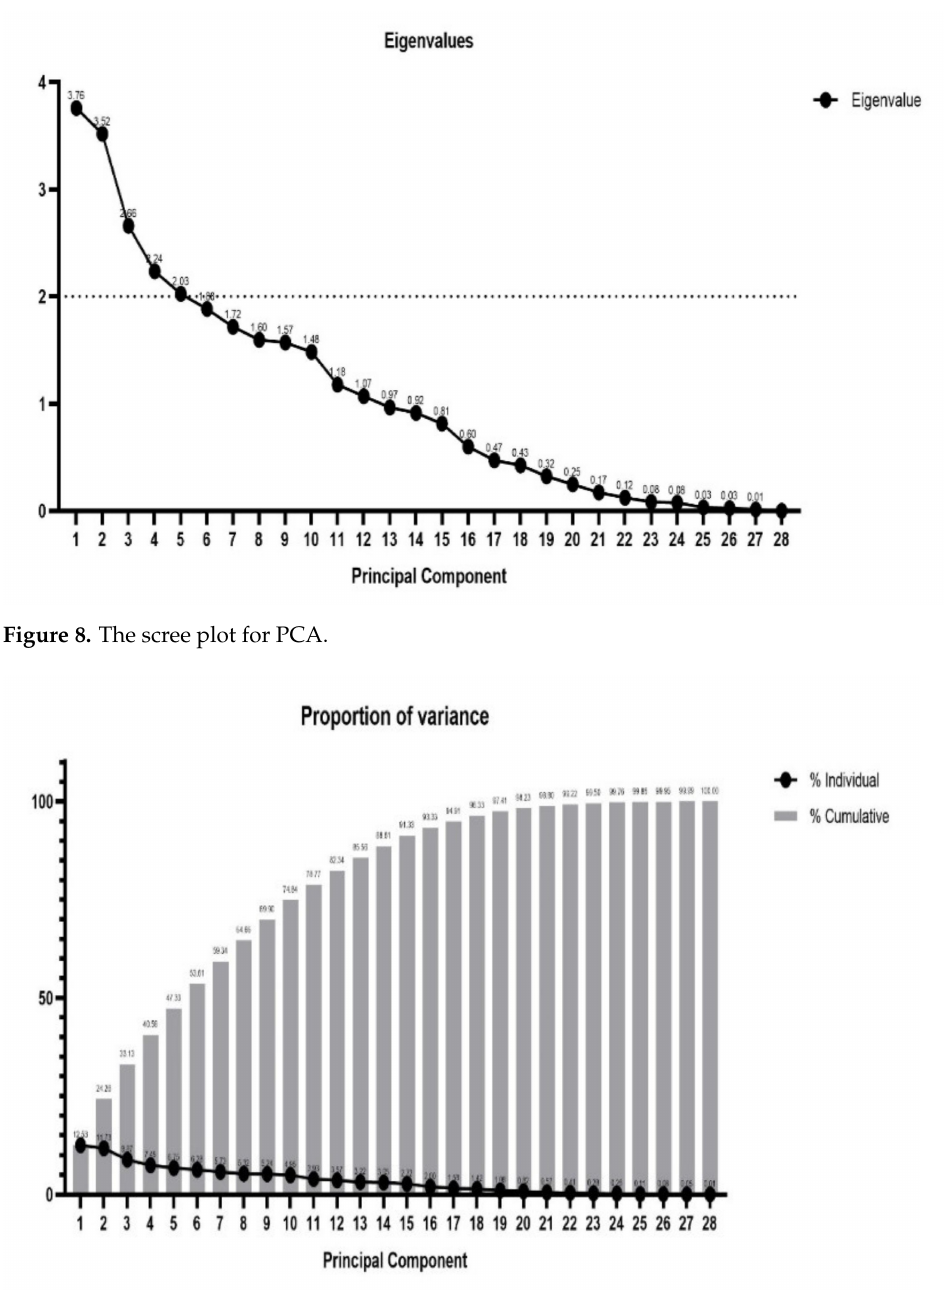
Figure 9. The proportion of